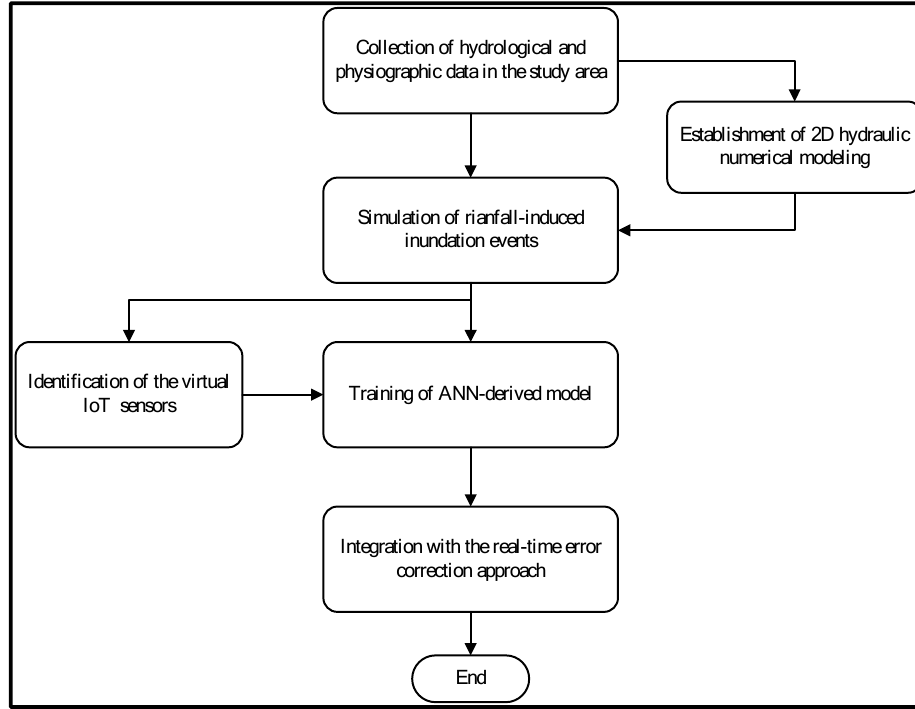
Figure 1. The graphic framework of the development and application regarding the proposed SM_EID_VIOT model.